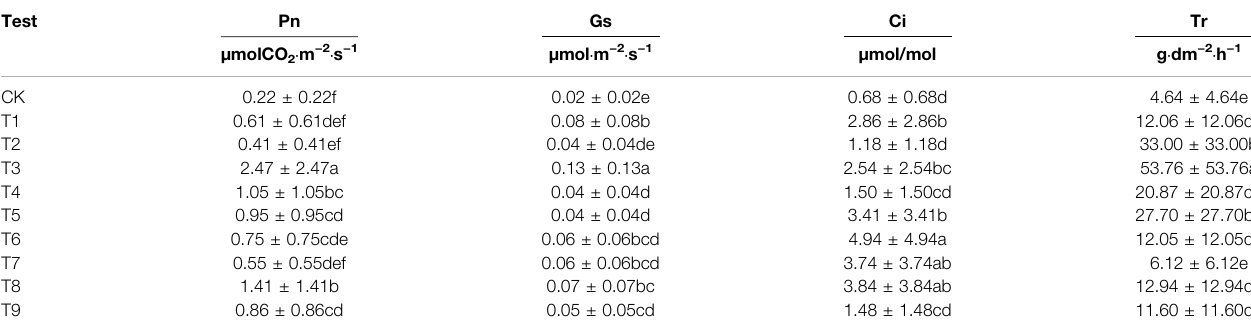
Note: Values in the table are mean ± standard deviation, different lowercase letters after the data in the same column indicate signi fi cant differences ( p < 0.05).